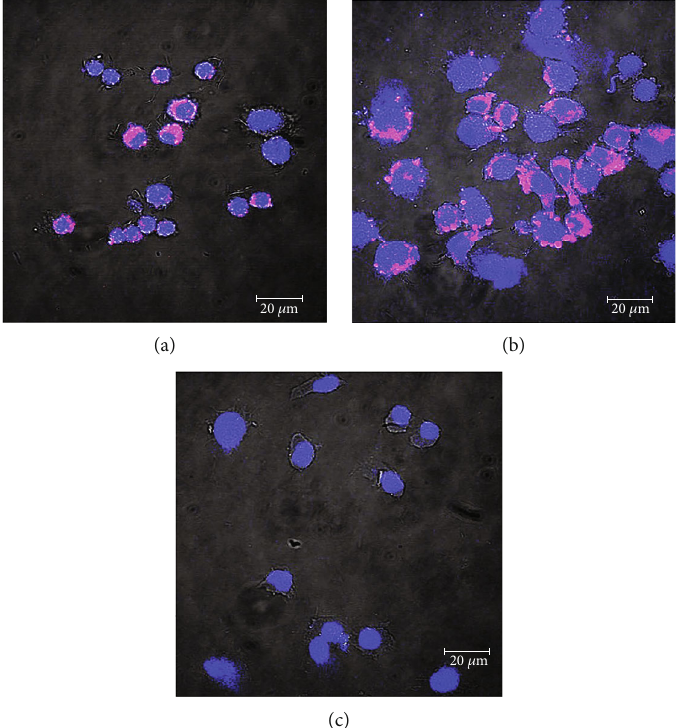
Figure 4: Cellular uptake of guttiferone E-loaded liposomes by MH-S cells examined under a CLSM. MH-S cells in culture were incubated for 24h at 37 ° C with 30 μ g (a) and 50 μ g (b) rhodamine-DPPE-labeled liposomes. (c) Control. Blue and red colors correspond to the nucleus and liposomes,